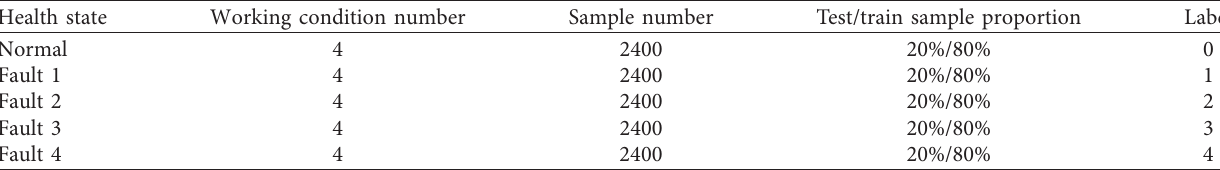
Table 3: Data description of CNN-M.